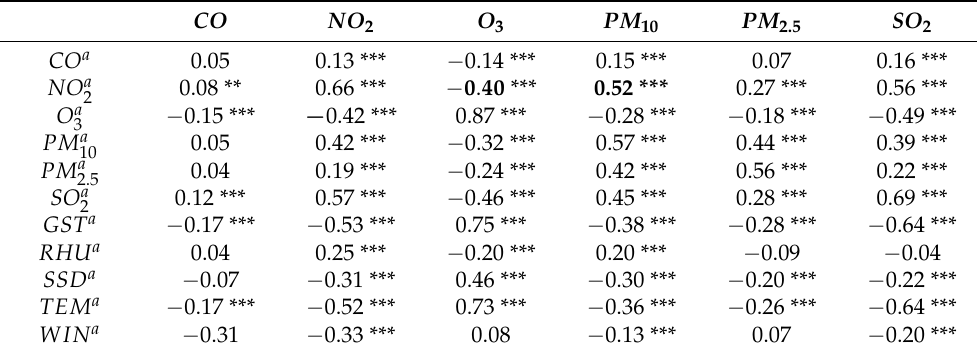
Table 4. The Pearson correlation coefficients between the meteorological variables and air pollutant concentrations in 2016.